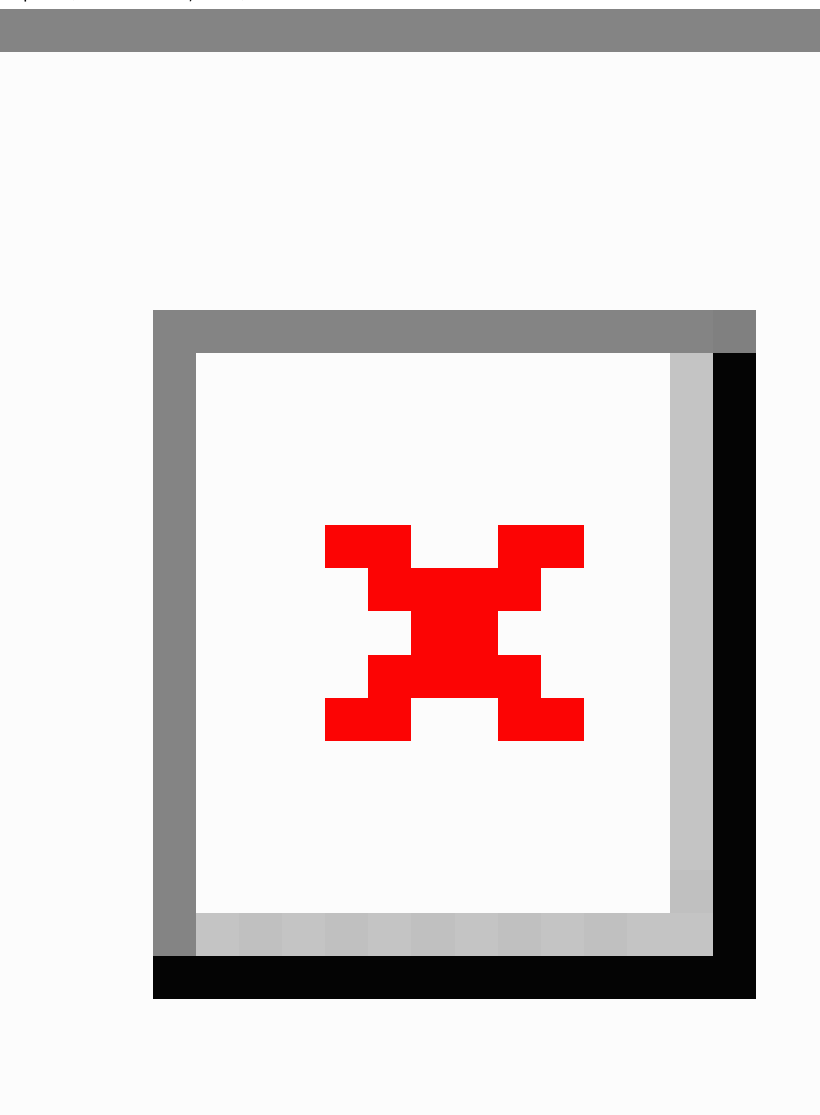
Figure 4. Retention in an online behavioral risk survey among participants reporting only male partners in the past 12 months by self-identified sexual orientation of the participant (United States,